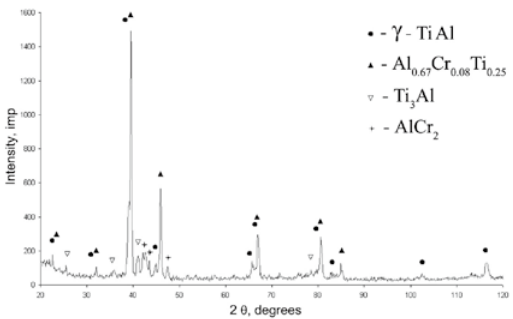
Fig.7 X-ray diffraction pattern of TiAlCr